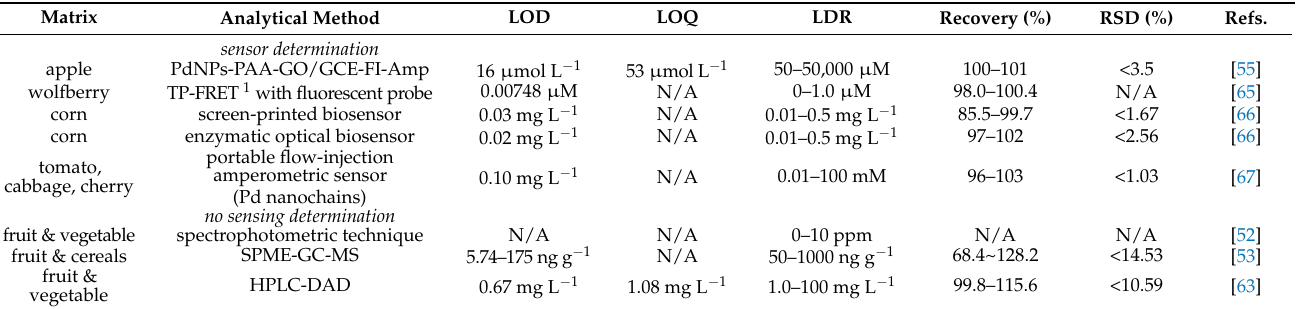
Table 4. Analytical performance of sensing and no-sensing determinations applied to vegetable and fruit matrix. The term “N/A” means the information is absent in the